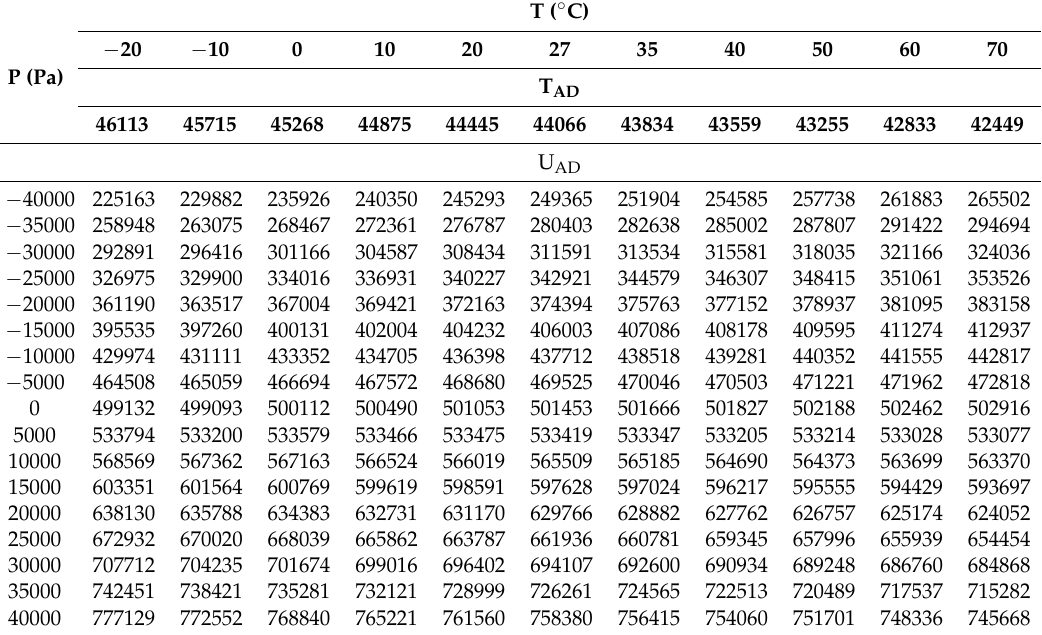
Figure 4. Set-up of calibration experiment. Table 1 . Data calibration.